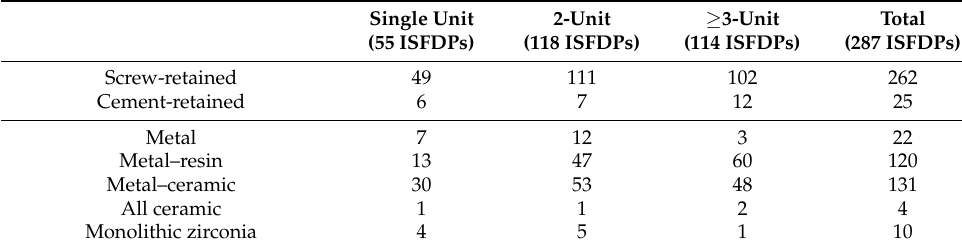
Table 3. Prosthetic conditions (retention type and materials of the